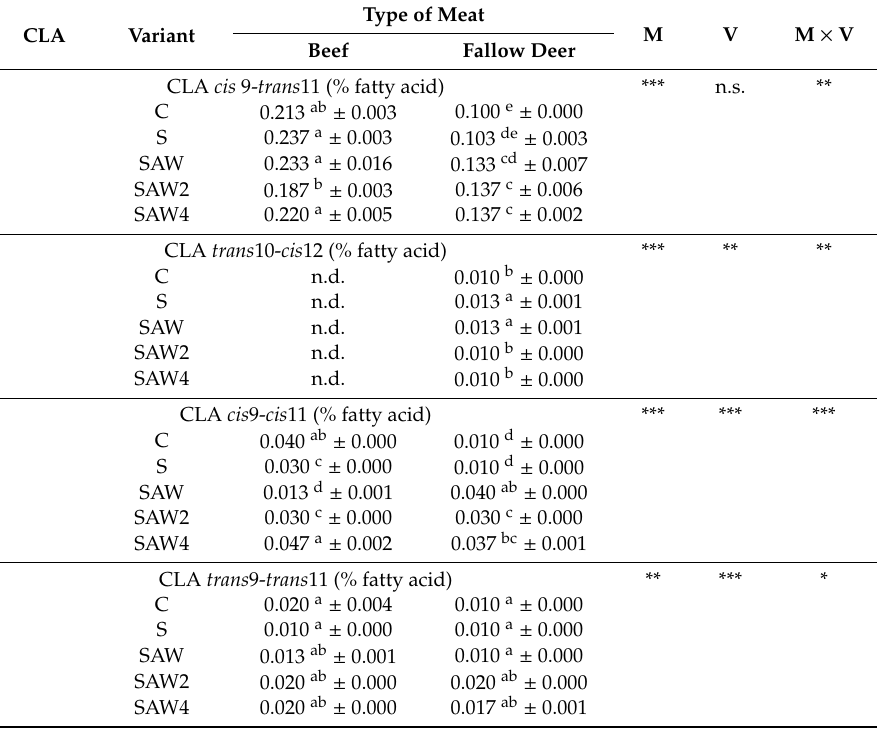
Table 9. Profile of conjugated linoleic acid (CLA) isomers in fatty acid profile of fermented sausages made from fallow deer and beef meat with di ff erent additives (mean ± standard